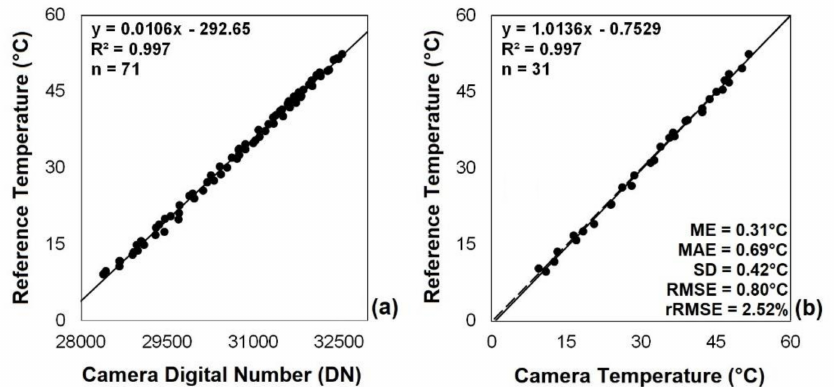
Figure 8. Linear regression models of the proximal calibration analysis. ( a ) calibration model between DN values extracted from raw images and reference temperature data; ( b ) validation model between TIR calibrated temperature and reference data. Dashed line = 1:1 line; solid line = linear regression line; n = number of samples; R 2 = coe ffi cient of determination; ME = mean error; MAE = mean absolute error; RMSE = root mean square error; rRMSE = relative RMSE p < 0.001 for all R 2